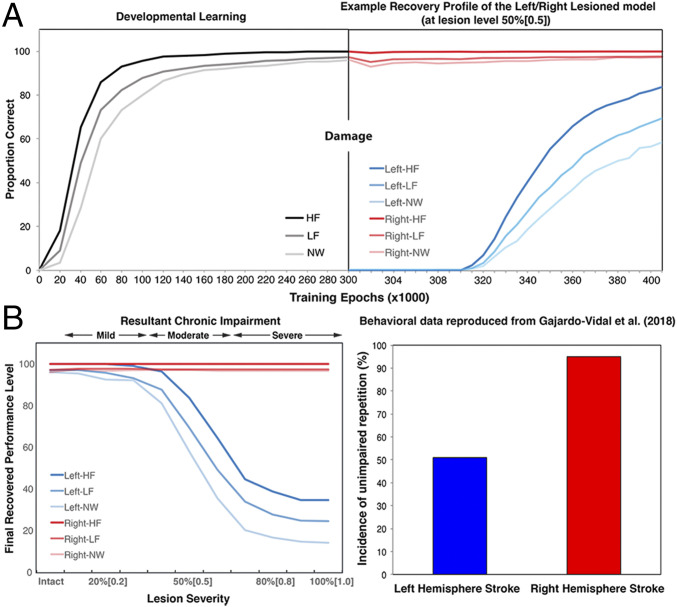
(A) The developmental learning trajectory of the model before damage, and the recovery profile after damage (moderate lesion 50% [0.5]) to the left or right hidden layer 1, simulating a left or right hemisphere stroke and recovery. Note that the unequally spaced time scales for the relearning period were made to clearly demonstrate the model’s relearning in different periods. (B) The recovered performance of the left-lesioned model and the right-lesioned model as a function of lesion levels (a combination of unit damage and noise; see the Chronic Aphasia after Left but Not Right Hemisphere Stroke section for details). “Intact” means the model without lesion. The behavioral data of unimpaired repetition performance were reproduced from Gajardo-Vidal et al. (17). HF, high-frequency words; LF, low-frequency words; NW, nonwords; LH, left hemisphere; RH, right hemisphere.